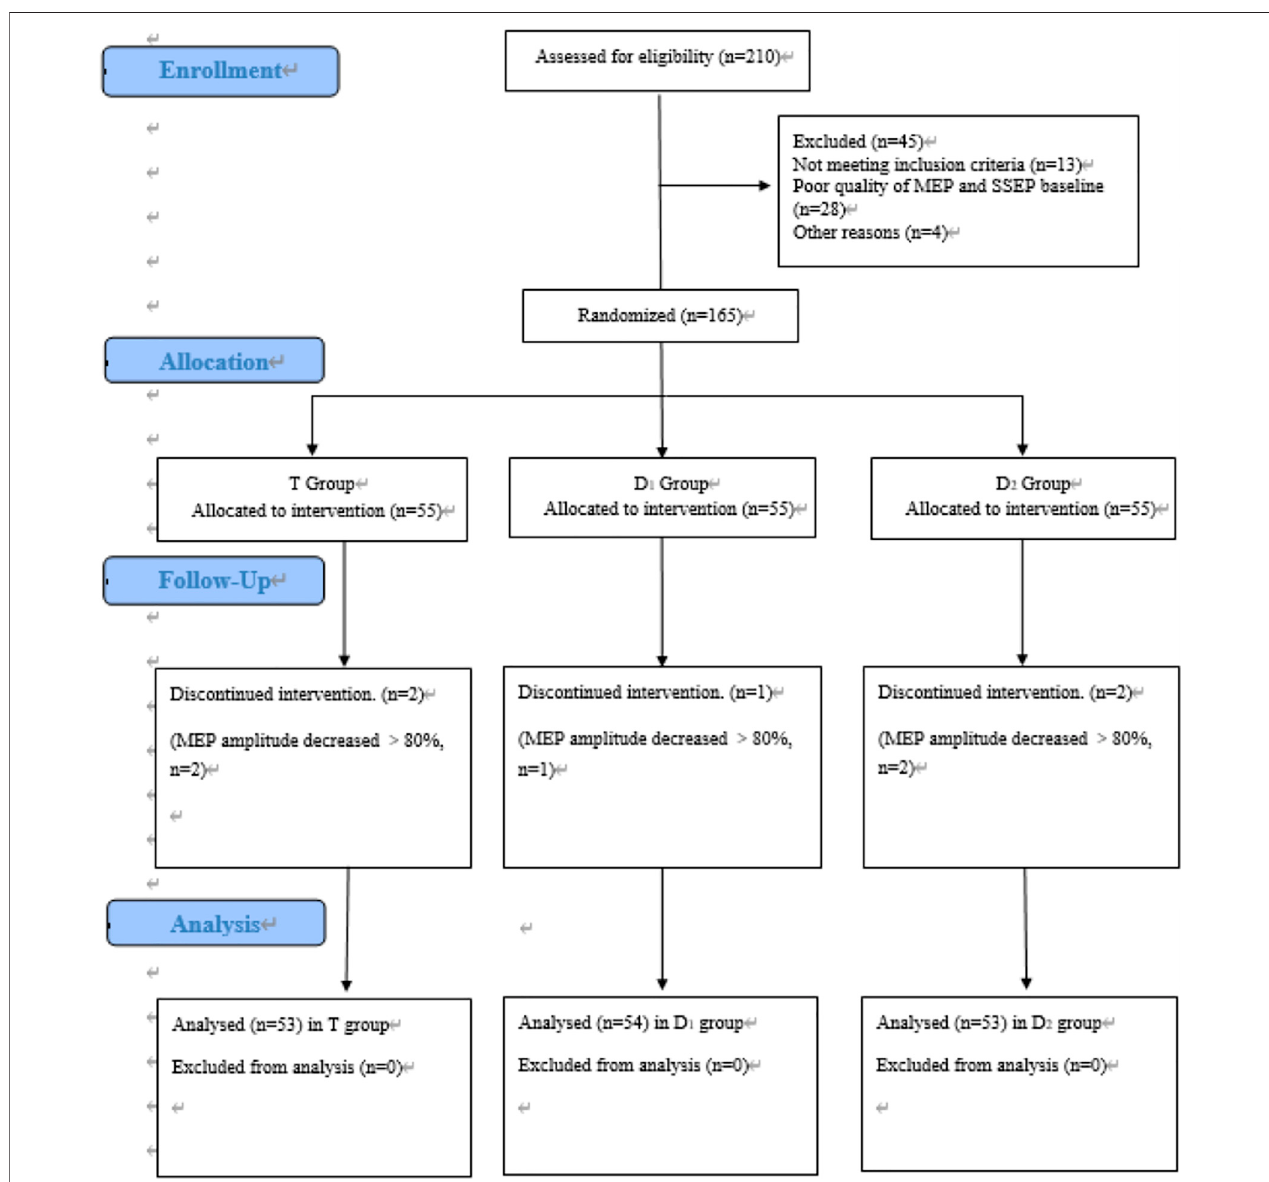
FIGURE 1 | CONSORT fl ow diagram of patients ’ inclusion. MEP, motor evoked potential. SSEP, somatosensory evoked potential. T group: propofol- and